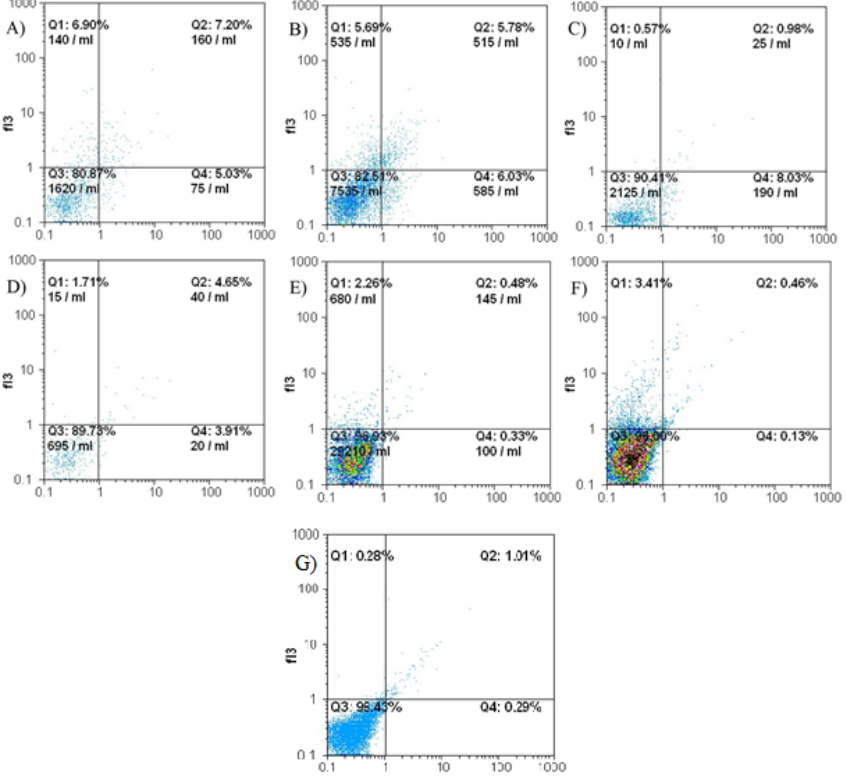
Figure 3. Dot plots of the HT-29 cells apoptotic events induced by FeSO 1.56 mM/mL respectively; D, E, F: FeS04-NPs, 6.25, 3.125, 1.56 mM/mL respectively, and G: Ctrl), where: where Q4: early apoptotic cells, Q3: viable cells, Q2: late apoptotic cells and Q1: necrotic cells.